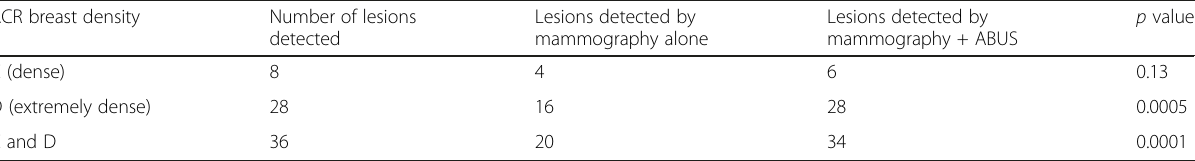
Table 3 Comparison between ABUS and mammography in the detection of lesions in patients with dense breasts ACR C and ACR D. t test was used to compare between the results with p value < 0.05 considered